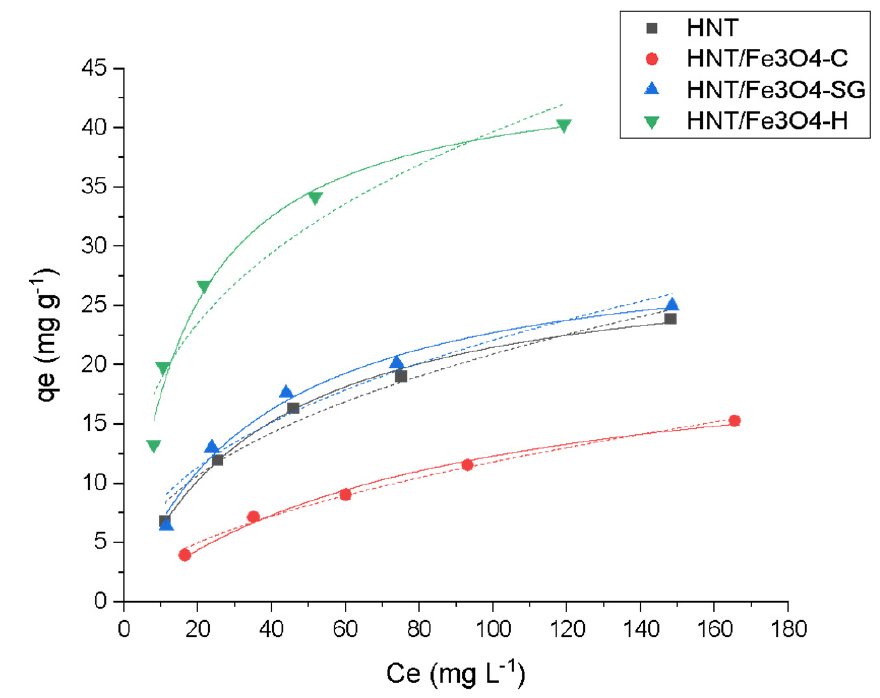
Figure 7. Adsorption profiles Langmuir (—) and Freundlich (…) for Ofloxacin (OFL) on HNT ( ■ black), HNT/Fe 3 O 4 -C ( ⬤ red), HNT/Fe3O4-H ( ▲ blue) and HNT/Fe 3 O 4 -SG ( ▼ green) (Experimental